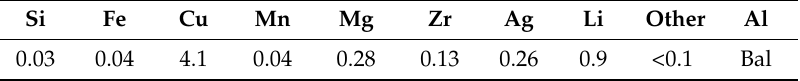
Table 1. Chemical composition of 2195 aluminum alloy (wt.